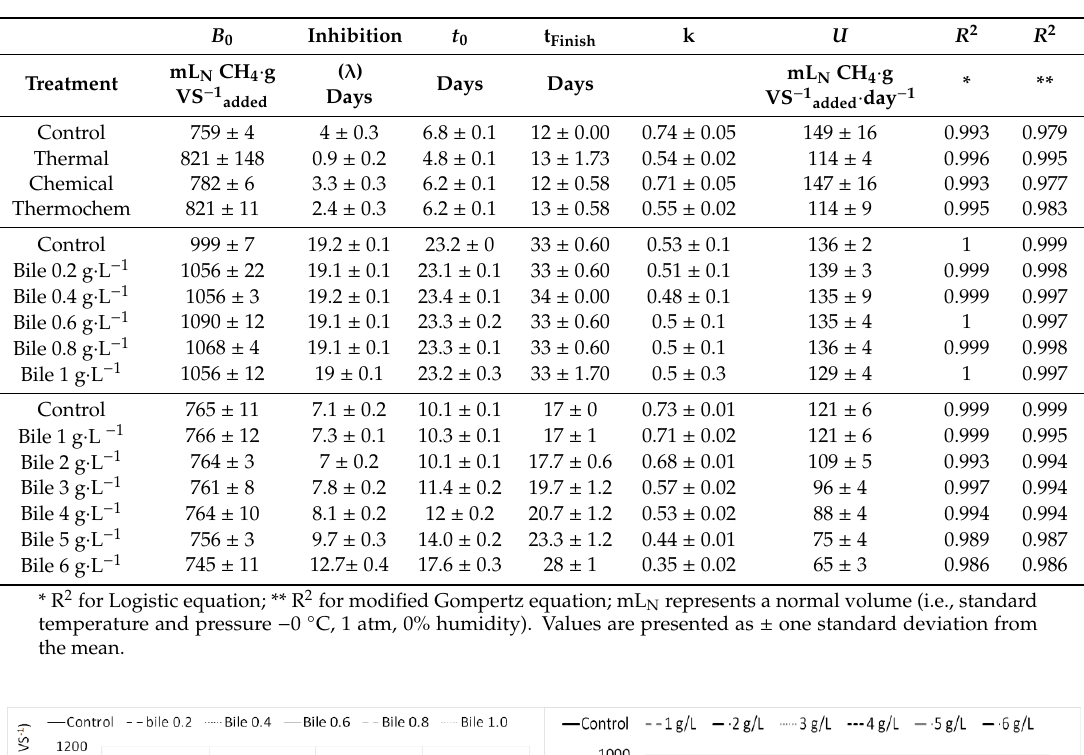
Table 2. Kinetics analysis of treatment groups adapted from [42,43].